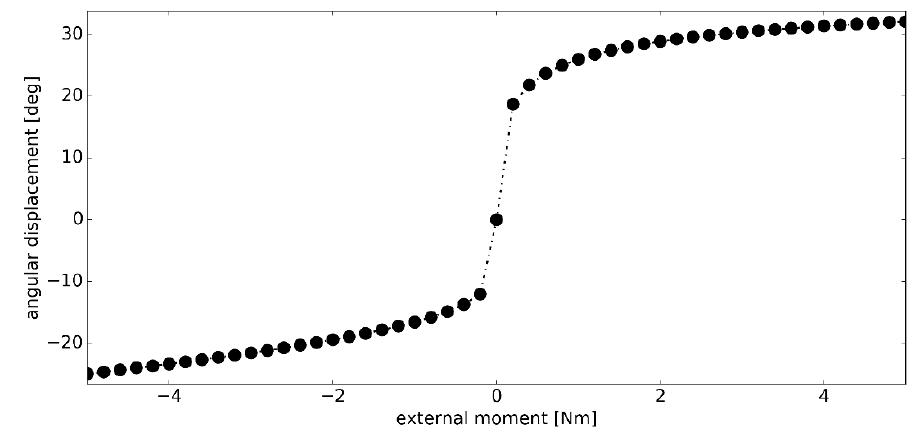
Figure 11. The angular displacement ∆ θ versus the external moment M ext in simulation #3.